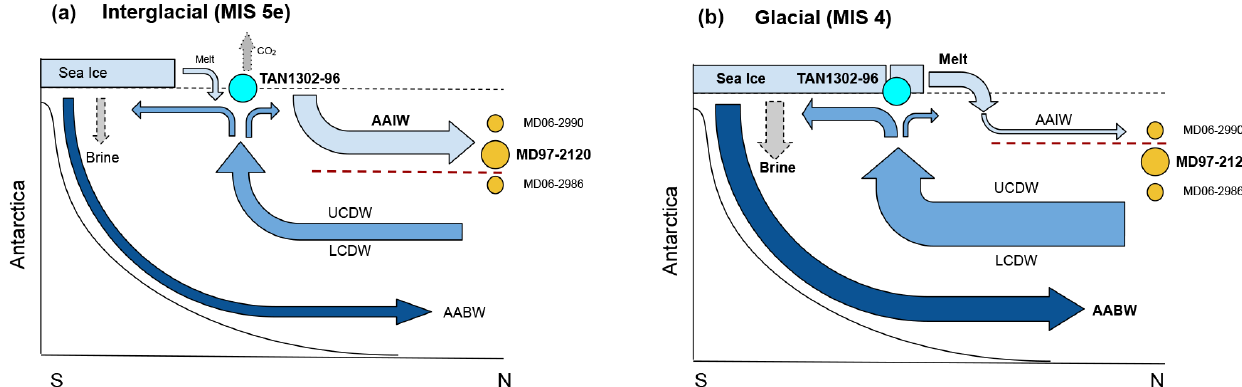
Figure 7. Schematic of changes in southwestern Pacific sector sea ice coverage and water mass geometry between interglacial and glacial stages. Panel (a) depicts interglacial conditions where sea ice coverage is minimal and freshwater input from summer sea ice melt is low. This lack of freshwater input allows AAIW to subduct to deeper depths and bath core MD97-2120, capturing the higher δ 13 C signature of the overlying AAIW waters. The AAIW-UCDW interface (red dashed line) is located beneath MD97-2120. CO 2 outgassing is occurring as a carbon-rich Circumpolar Deep Water upwell near Antarctica. Panel (b) depicts glacial conditions where sea ice expansion has occurred beyond TAN1302-96, increasing brine rejection, and stabilizing the water column. As a result of the increased sea ice growth, subsequent summer melt increases the freshwater flux into the AAIW source region and increases AAIW buoyancy. This buoyancy gain shoals the AAIW-UCDW interface above core MD97-2120, causing the core site to be bathed in low δ 13 C UCDW. The shoaling of AAIW causes an indirect expansion of CDW, increasing the glacial carbon stocks of the deep ocean, while sea ice reduces CO 2 outgassing via the capping